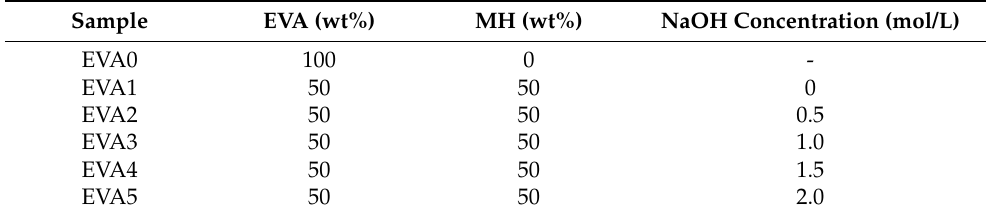
Table 1. Formulations of neat EVA and EVA/MH